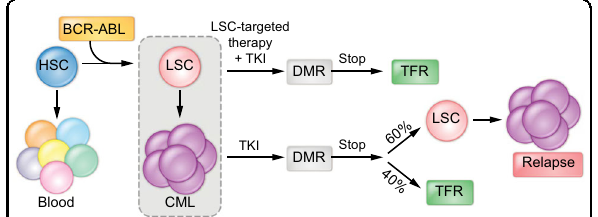
Fig. 1 Pathobiology and treatment of chronic myeloid leukemia. The chromosomal translocation t(9;22) transforms a single hematopoietic stem cell (HSC) into a leukemia stem cell (LSC) through expression of the oncoprotein BCR-ABL1, which leads to the development of chronic myeloid leukemia (CML) via constitutive kinase activity. Treatment with tyrosine kinase inhibitors (TKIs) constitutes the standard of care and effectively induces a deep molecular response (DMR), although TKI discontinuation trials have shown that 60% of patients relapse, while 40% reach treatment-free remission (TFR). Future therapies to improve the induction of TFR should combine TKIs with LSC-speci fi c drugs.